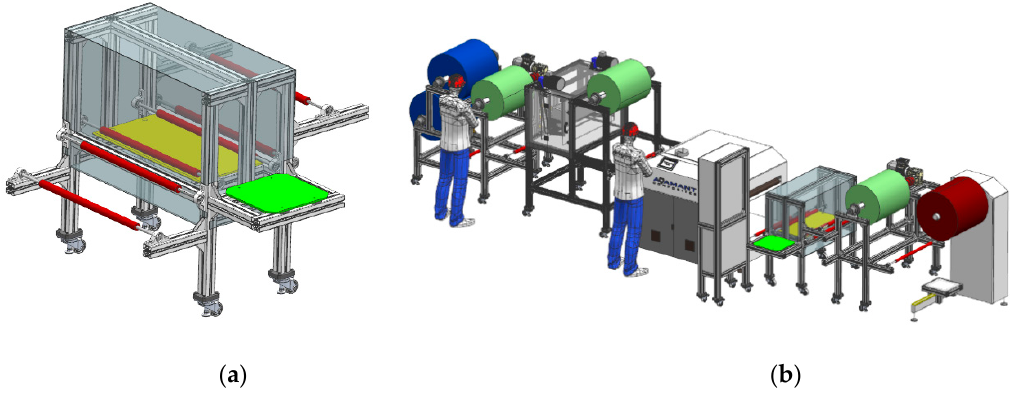
Figure 3. ( a ) CAD representation of the free-space quality module. ( b ) CAD representation of the dedicated module in position Control Point #2 of the R2R pilot line.